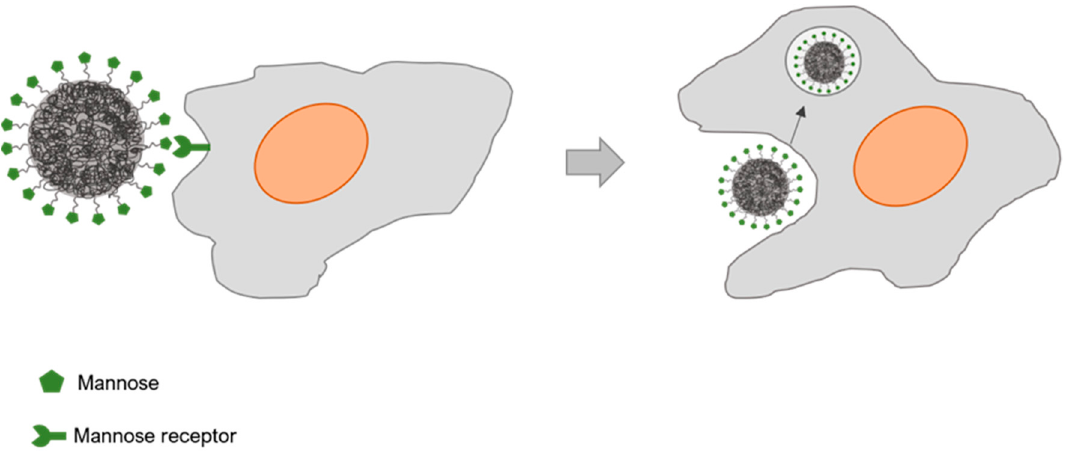
Figure 4. Glyconanoparticle interaction with macrophages through receptor mediated endocytosis mechanism.